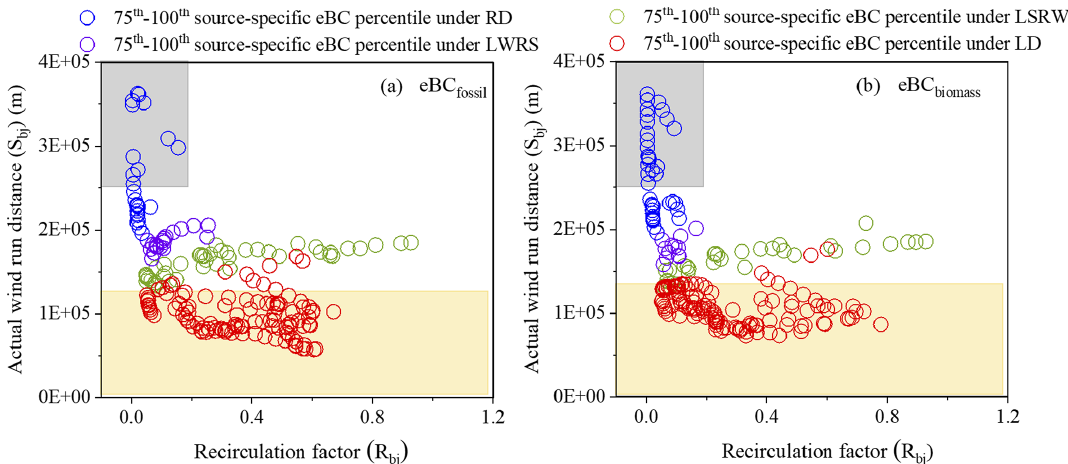
Figure 3. (a) The 75th–100th percentile mass concentrations of the e BC from fossil fuel combustion ( e BC fossil ) and (b) the e BC from biomass burning ( e BC biomass ) under local-scale dominance (LD, red circle), local-scale strong and regional-scale weak (LSRW, green circle), local-scale weak and regional-scale strong (LWRS, purple circle), and regional-scale dominance (RD, blue circle). S bj is actual wind run distance at 100m height, R bj is the recirculation factor, the grey area indicates good ventilation ( S bj ≥ 250km, R bj ≤ 0.2), and the yellow area indicates air stagnation ( S bj ≤ 130km).